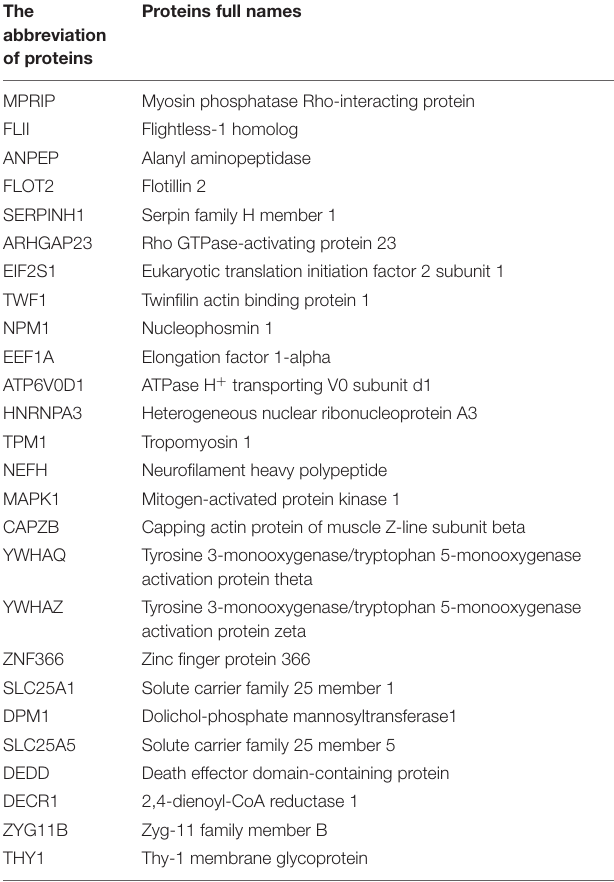
TABLE 1 | The 26 possible target proteins of